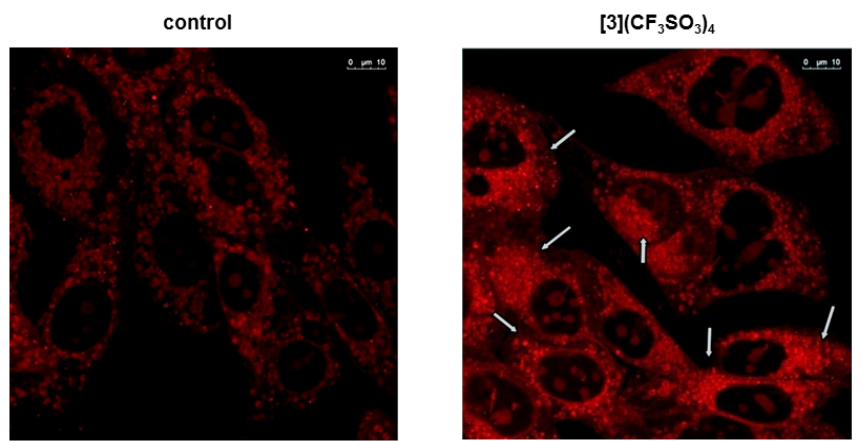
Figure 6. Mitochondrial outer membrane permeability in A-549 cells with (500 nM) and without (control) metalla-rectangle 3 (white arrows show aggregations of